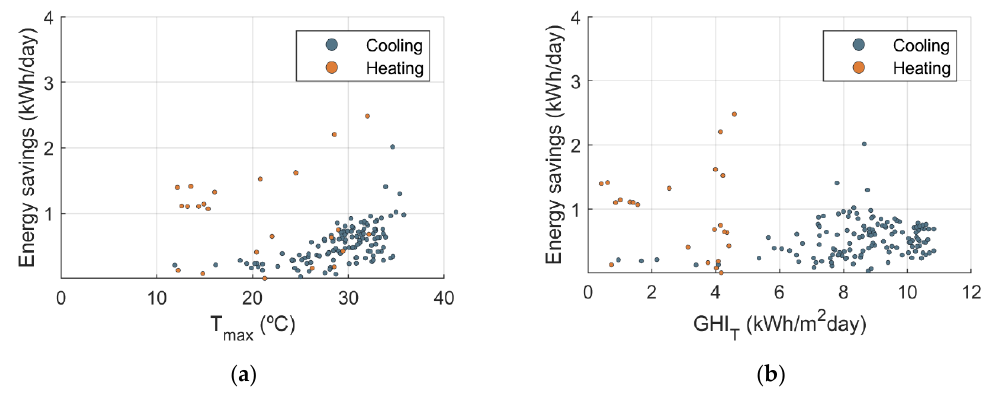
Figure 14. ( a ) Relation between daily energy savings and daily maximum outdoor temperature. ( b ) Relation between daily energy savings and daily total global horizontal irradiance.